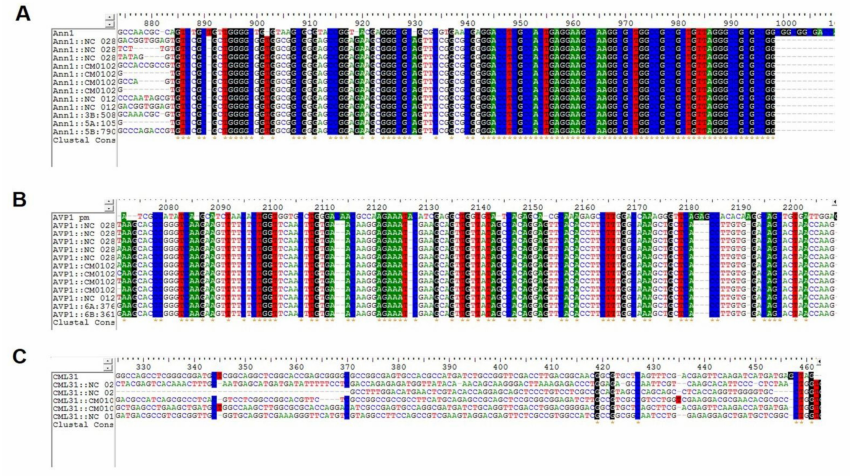
Figure 2. Haplotype-led comparison to visualize the occurrence of many to few haplotypes of drought genes in different millets. ( A ) Ann1 showed dense haplotype pattern ( B ) Moderate and scattered haplotypes in AVP1 ( C ) CML31 has the lowest number of